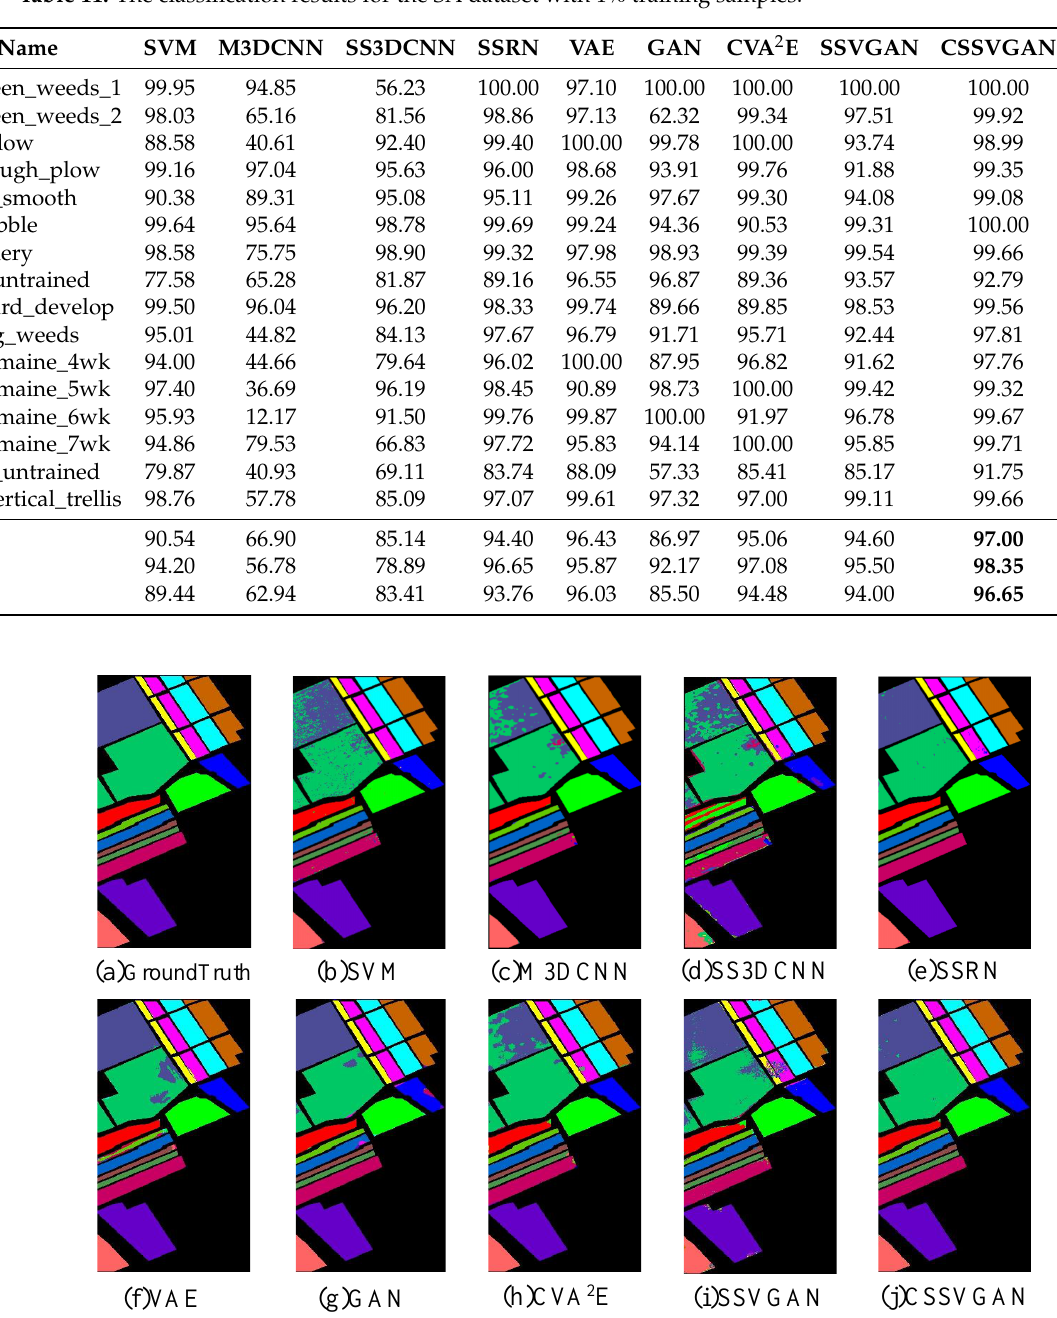
Table 11. The classification results for the SA dataset with 1% training samples.